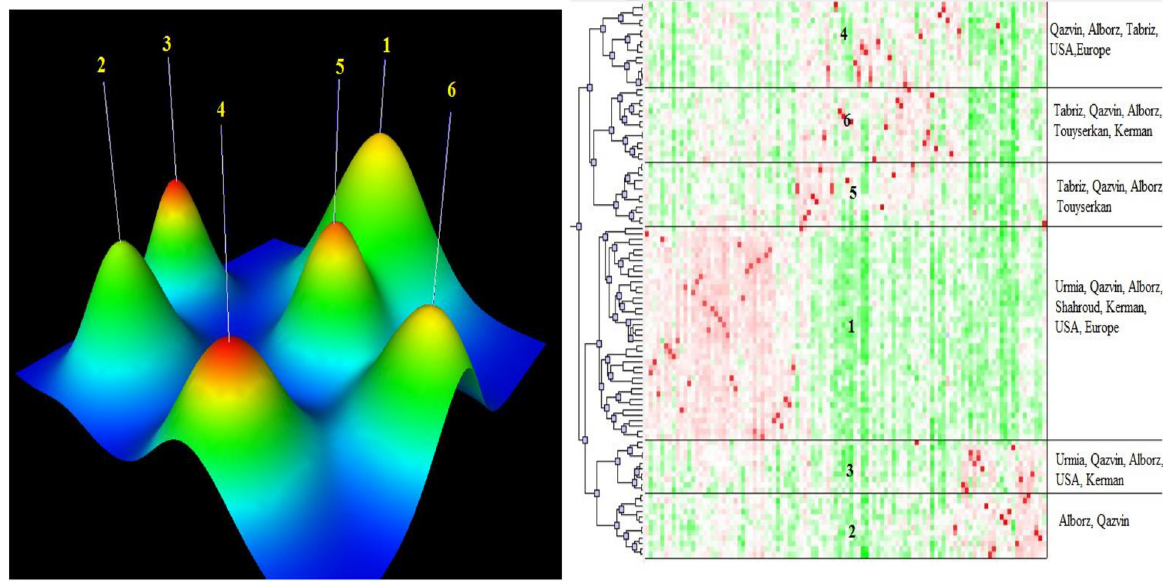
Fig 1. Mountain visualization of k-means clustering analysis combined with multidimensional scaling.